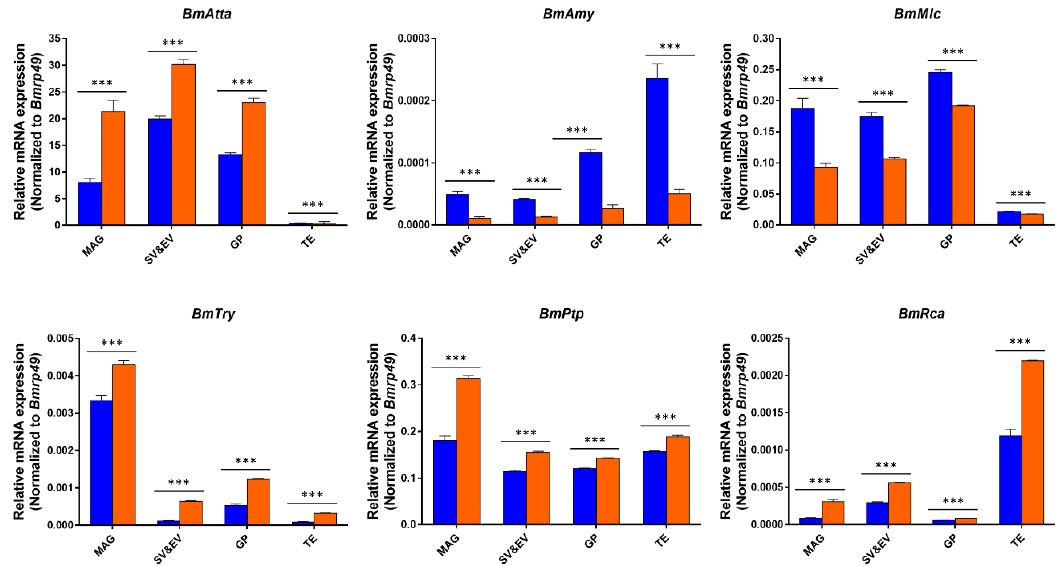
Figure 5. Expression of genes associated with sperm development and motility is altered in Δ BmSfp62 individuals. mRNA levels of BmAtta (GU244351.1), BmAmy (NM_001173153.1), BmMlc (XM_012694217.1), BmTry (XM_012688545.2), BmPtp (NM_001047017.1), and BmRca (XM_004930660.3). WT is in blue, Δ BmSfp62 is in orange. mRNA expression level was normalized to Bmrp49 . The data shown are means ± S.E.M. ( n = 3). Asterisks indicate significant differences with a two-tailed t -test: *** p < 0.001.